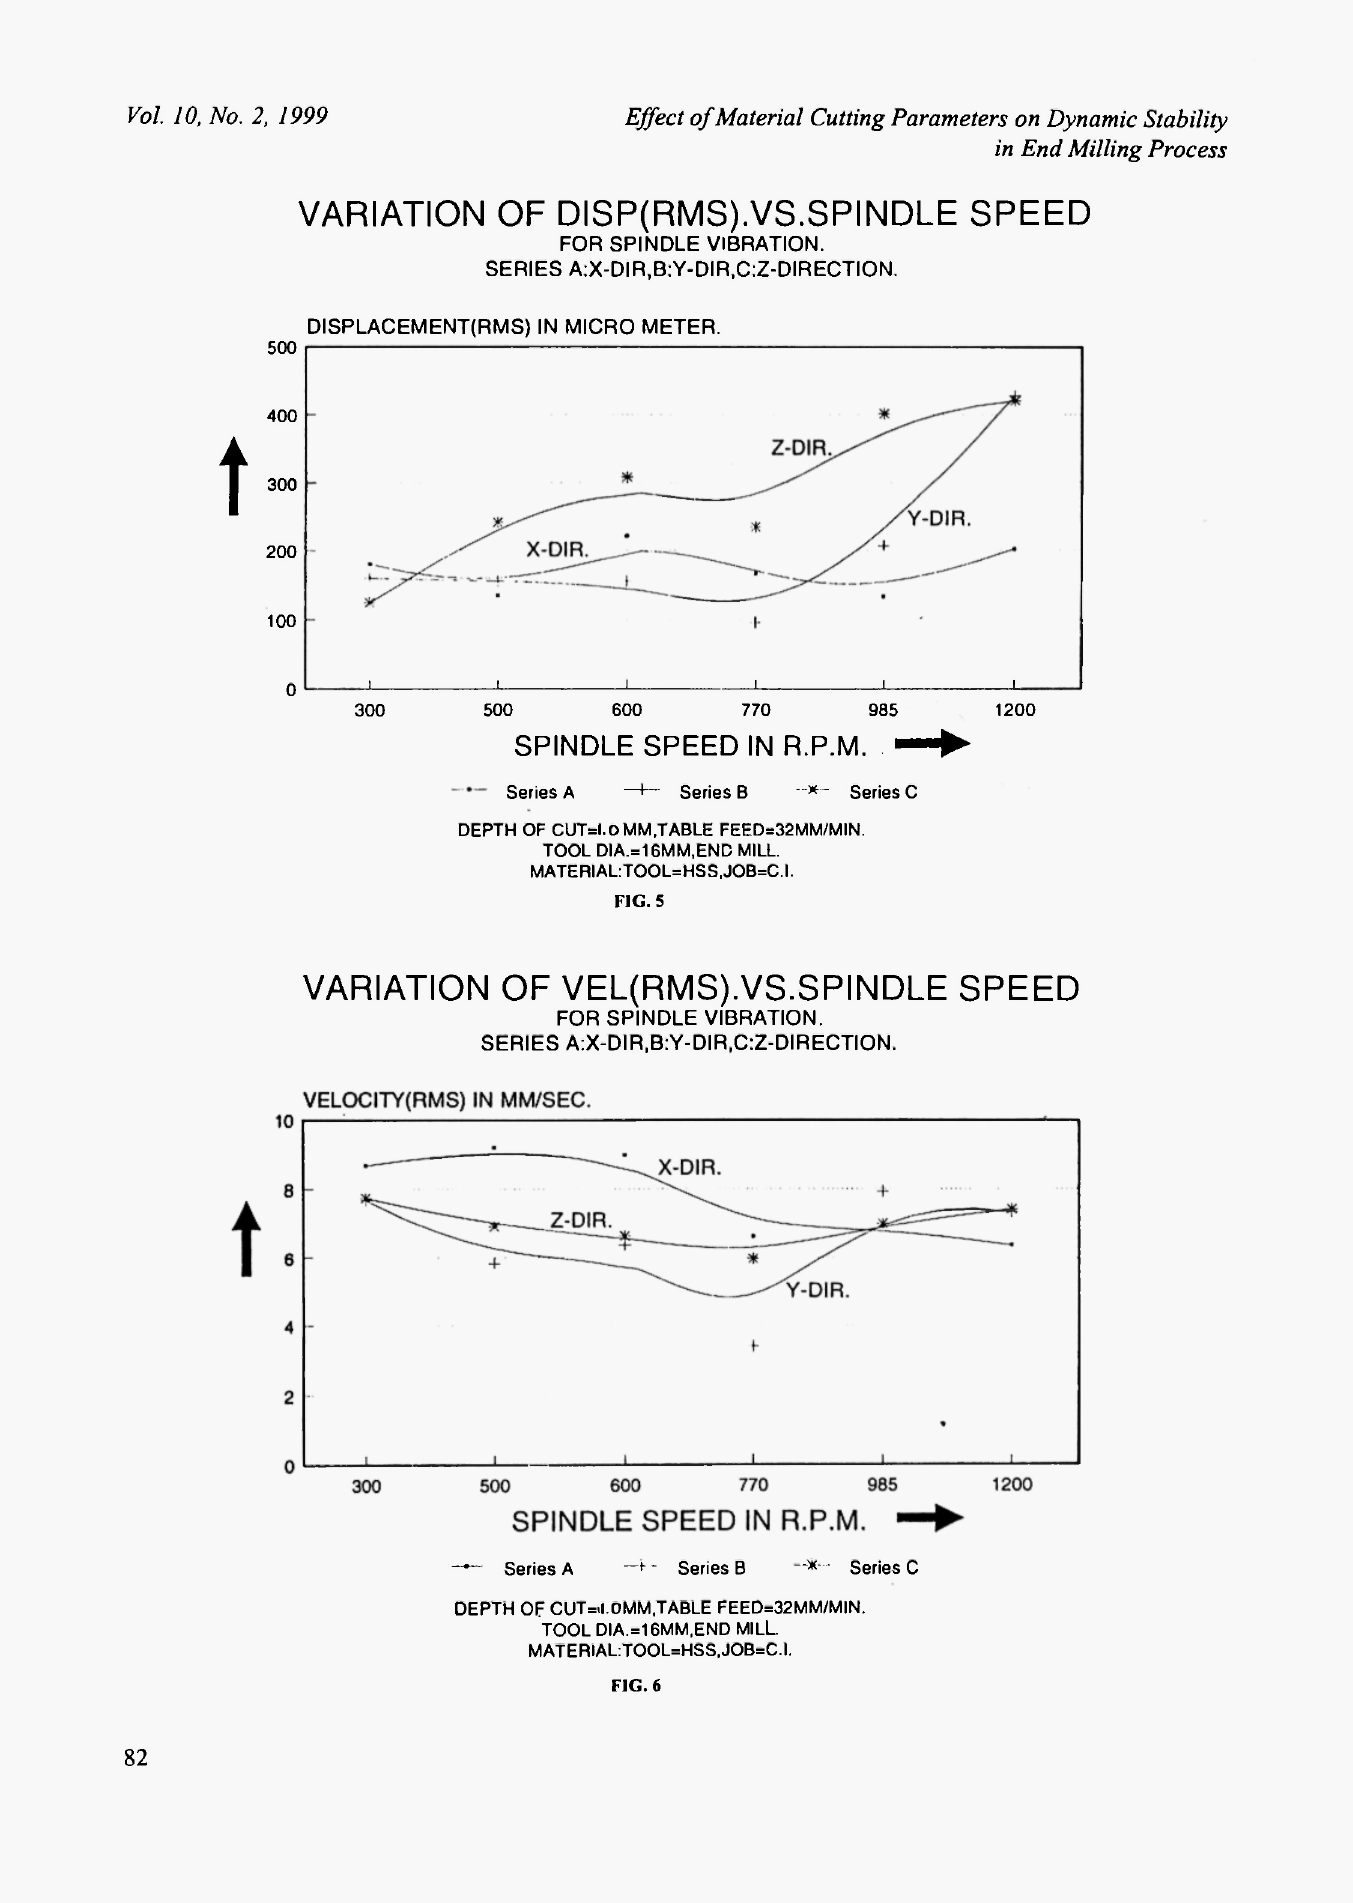
I I L SPINDLE SPEED IN R.P.M. —• Series A —y- Series Β --*- Series C DEPTH OF CUT=I.OMM,TABLE FEED=32MM/MIN. TOOL DIA =16MM,END MILL. MATERIAL:TOOL=HSS,JOB=C.I.